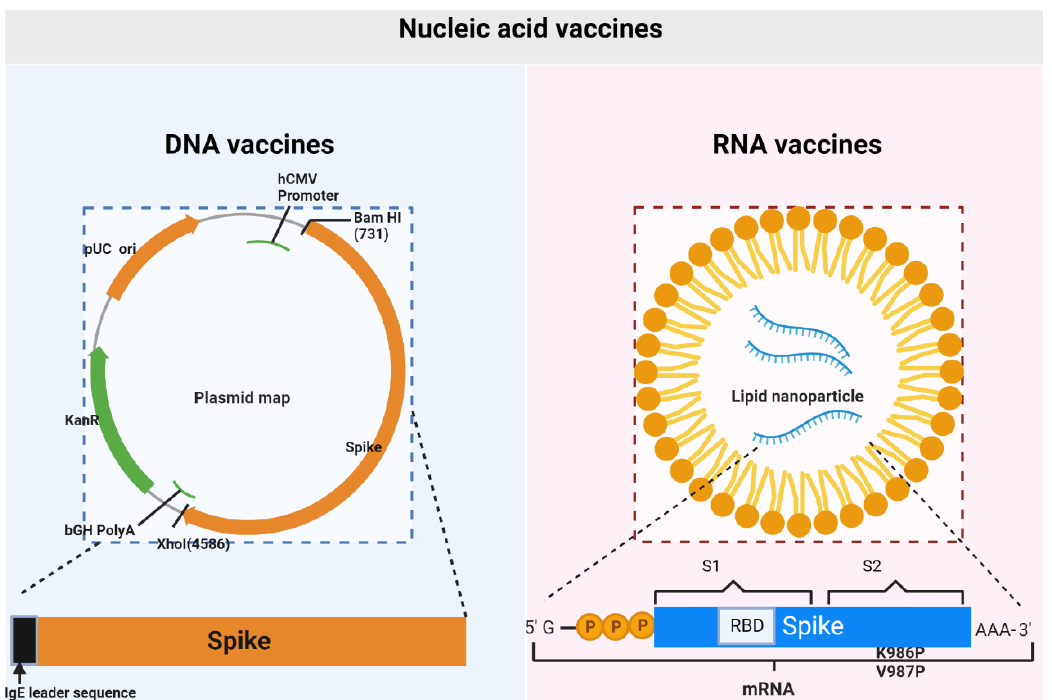
Figure 2. Schematic diagram of COVID-19 synthetic DNA and RNA vaccine constructs. Schematic diagram of COVID-19 synthetic DNA vaccine constructs ( left ), where plasmids containing the IgE leader sequence and SARS-CoV-2 spike protein insert are shown. Schematic diagram of COVID-19 synthetic RNA vaccine constructs ( right ), showing the S1 (N-terminal furin cleavage fragment), S2 (C-terminal furin cleavage fragment), and RBD (receptor-binding domain). The positions of the P2 mutation (K986P and V987P) are indicated.